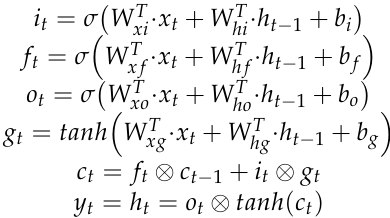
Figure 2. Elman network algorithms.